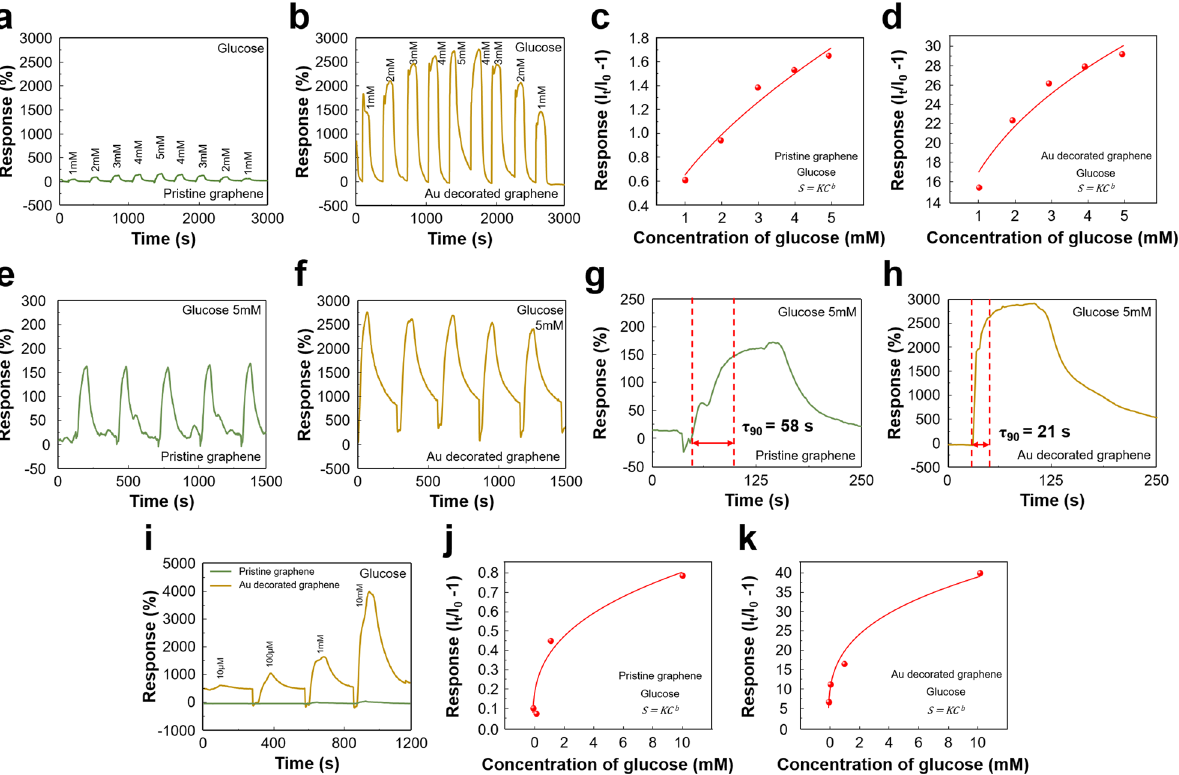
Fig. 4 Glucose detection characteristics of the graphene SFETs. Glucose detection responses using a pristine graphene and b Au-decorated graphene. Calibration of responses for c pristine graphene and d Au-decorated graphene to 1 – 5 mM of glucose plotted using Freundlich equation. Repetitive curves of response to 5 mM glucose solution of e pristine graphene and f Au-decorated graphene. τ 90 value of g pristine graphene and h Au-decorated graphene response to 5 mM glucose solution. Detection limit measurements for i pristine and Au-decorated graphene. Calibration of responses for j pristine graphene, k Au-decorated graphene to 10 µM – 10 mM of glucose plotted using Freundlich